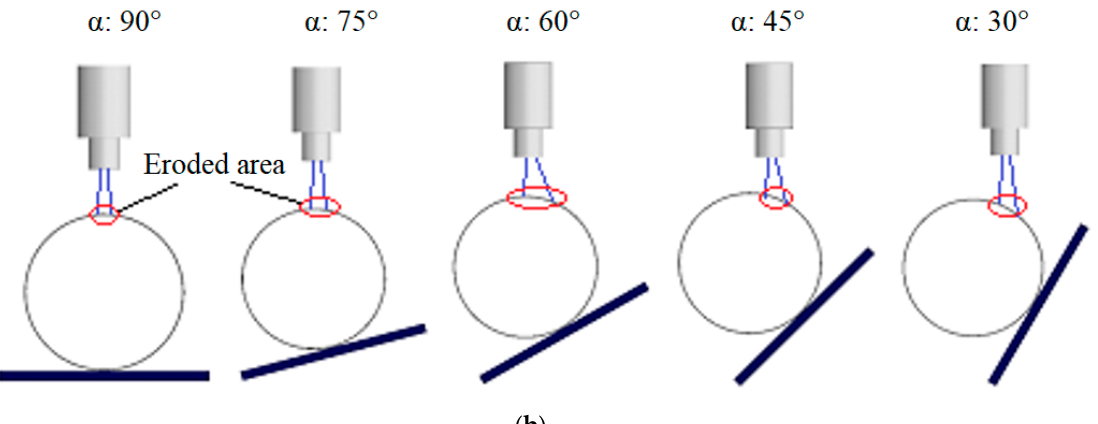
Figure 4. Pipe outer surface radial positioning test details: ( a ) SPE wear test design, and ( b ) schematic views of the variation of the impingement angle in the experiments (F: impact force, F n : normal force on laminate).